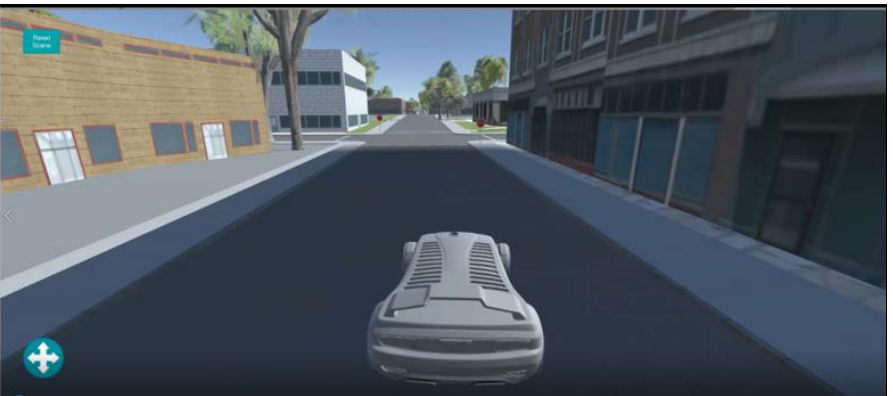
Figure 10. The mobile game in Android phone that allows user to drive a car.